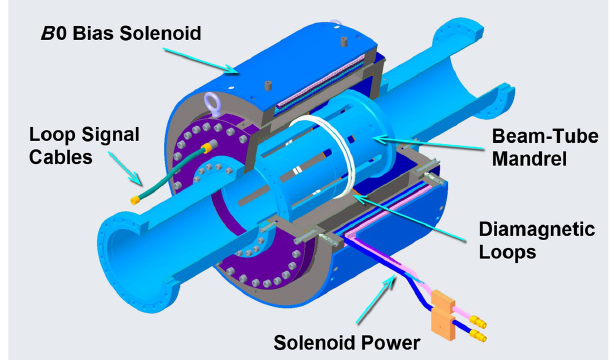
FIG. 2. DML apparatus. The bias solenoid is shown in purple. The beam pipe is shown in blue and the flux-conserving outer wall is shown in gray. Balanced-loop signal output cables are shown in green (Adapted from Ref. [21]).